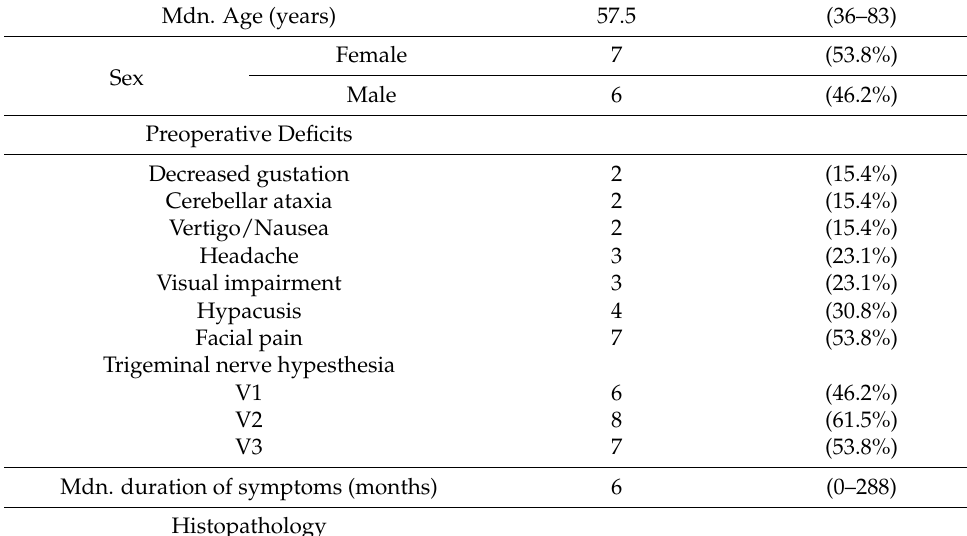
Table 1. Demographics, clinical presentation and tumour histopathology. Data shown as n = num-